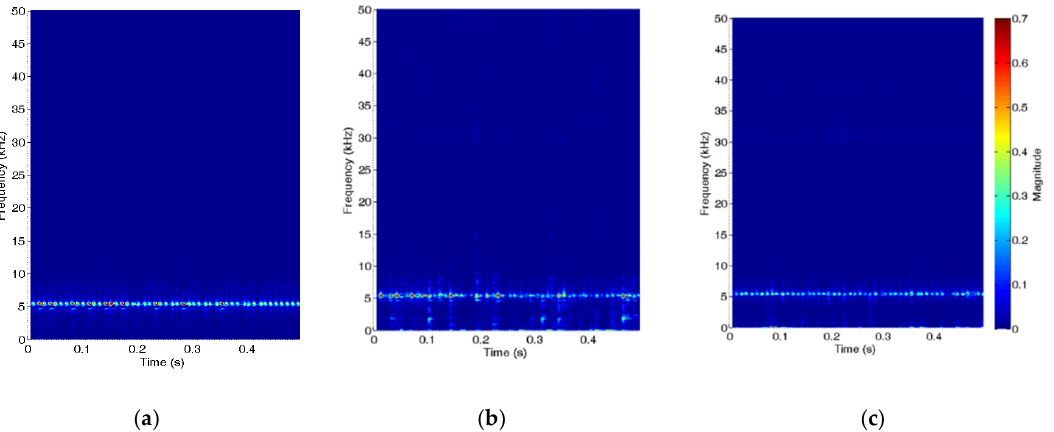
Figure 10. Results of spectrogram from the shallow delamination; ( a ) steel ball hammer, ( b ) 11-tooth gear, ( c ) 30-tooth gear.